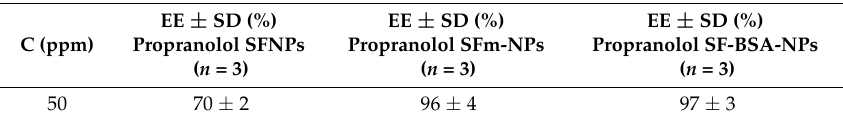
Table 6. Encapsulation Efficiency (EE) of magnetic silk fibroin and silk fibroin-bovine serum albumin nanoparticles encapsulated with propranolol.